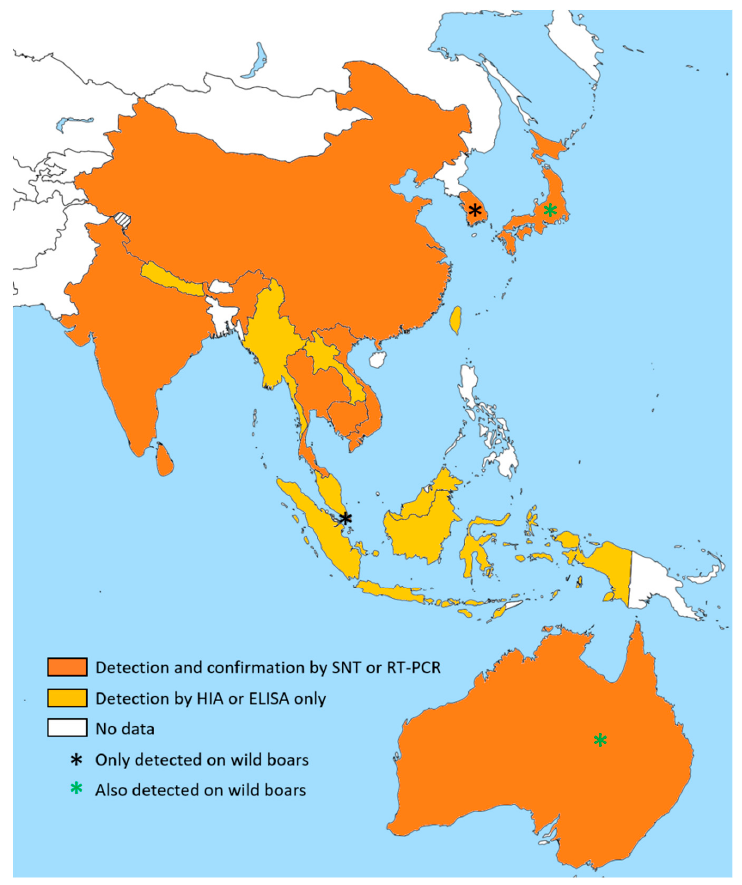
Figure 2. JEV detection in swine from 1966 to 2016, based on selected studies .